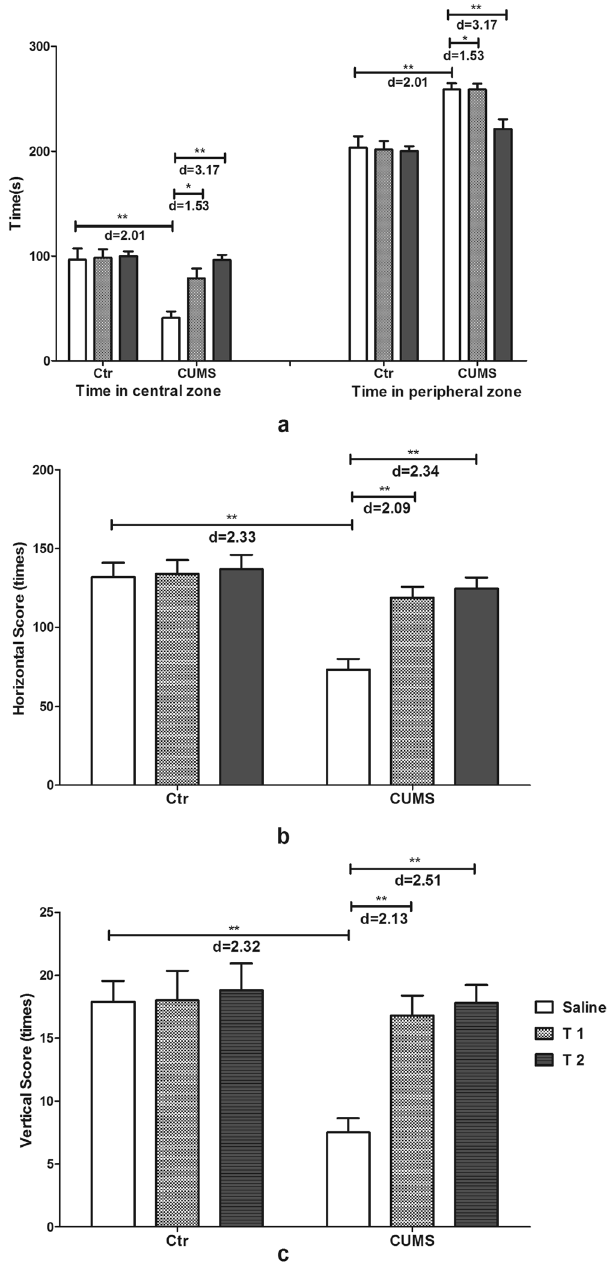
Figure 3. Effects of taurine on the behavior in the OFT. ( a ) Exploration time in the center and margin of rats. ( b ) Horizontal scores of rats in the OFT. ( c ) Vertical scores of rats in the OFT. Ctr, control group; CUMS, CUMS group; Saline, i.p. saline; T1, i.p. 200 mg/kg taurine; T2, i.p. 500 mg/kg taurine; All data are expressed as means ± SE and were analyzed by two-way ANOVA followed by Bonferroni’s multiple comparisons post hoc test (n = 10). * P < 0.003 vs. CUMS group; ** P < 0.00067 vs. CUMS group. d means Cohen’s d, d = 0.20 was considered as small effect size, d = 0.50 was considered as medium effect size, d = 0.80 was considered as large effect